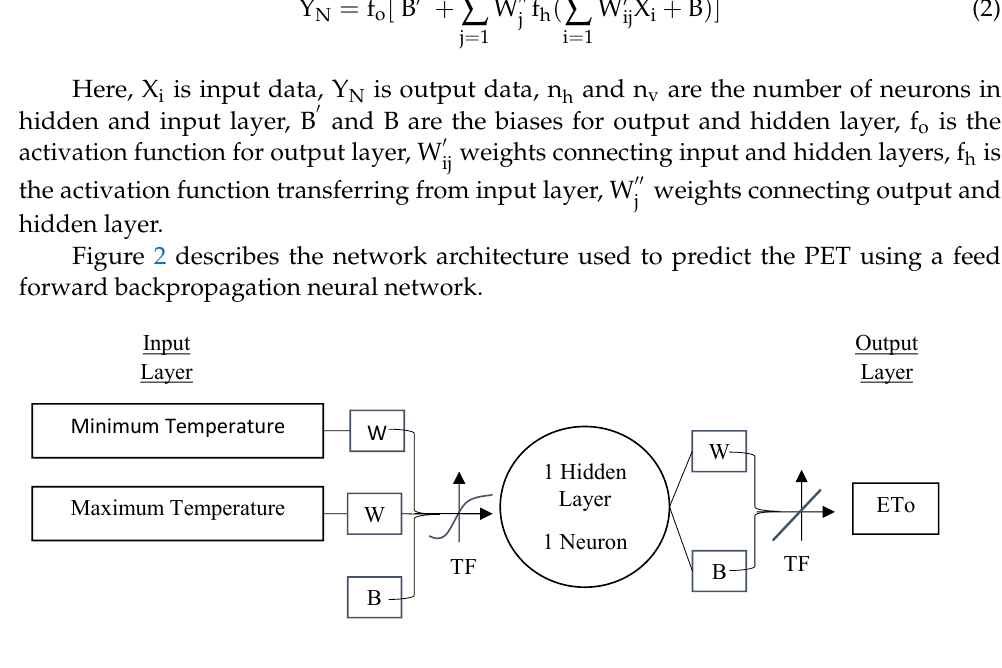
Figure 2. Artificial Neural Network used for training, validation and prediction (W, B and TF mean weight, bias and transfer function,